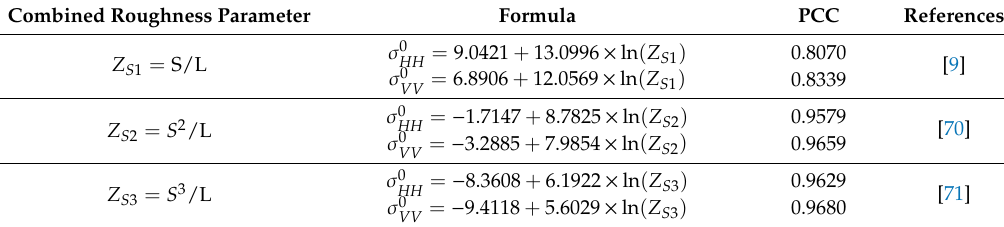
Table 4. Quantitative relationship between the three forms of combined roughness parameters and the soil backscattering coefficient.